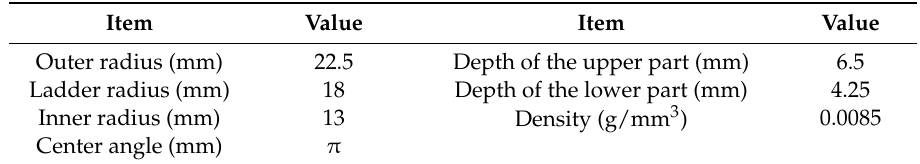
Table 2. Parameters of counterweight